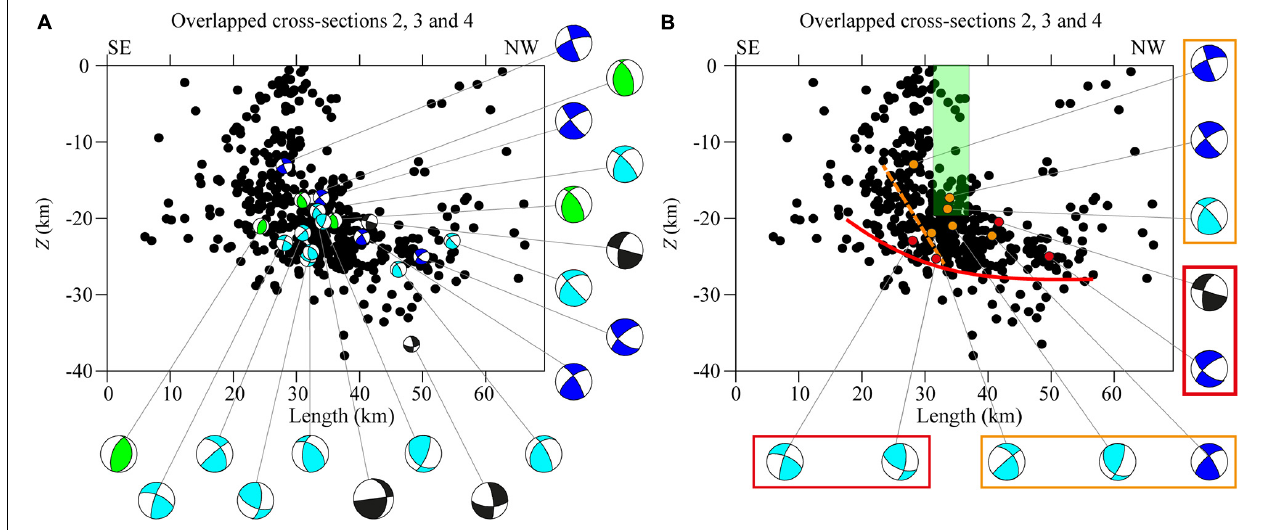
FIGURE 11 | Overlapped vertical cross-section maps 2, 3, and 4 of Figure 10 . (A) Hypocenters are reported as black circles, focal mechanisms are projected in cross-section. Beachball colors are described in Figure 5 caption. (B) Green rectangle indicates the MF system. Refer to the text for explanation of the superimposed sketched lines and of the rectangles outside the cross-section